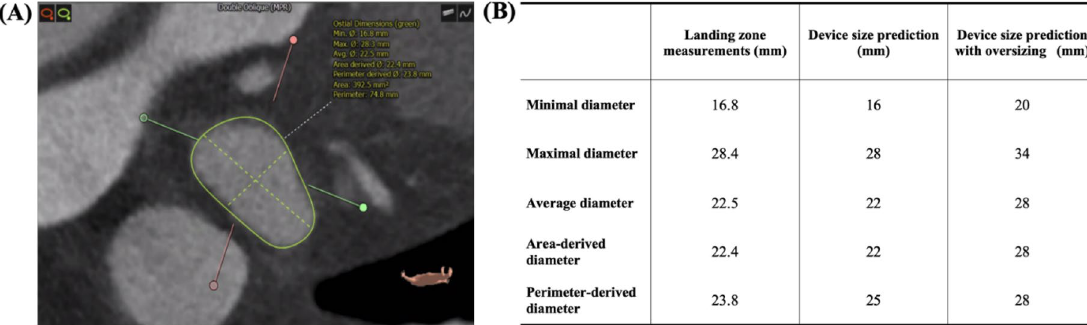
Figure 2. Device size prediction using landing zone measurements. ( A ) The landing zone of the left atrial appendage is located, and five different parameters are acquired: minimal, maximal, average, area-derived, and perimeter-derived diameter. Analysis was performed by 3mensio Workstation version 10.1 (Pie Medical Imaging, Maastricht, The Netherlands). ( B ) Device size is predicted by choosing the closest size to each parameter. Device size prediction with oversizing is performed by choosing the corresponding device size according to sizing gually. Using the bolus tracking technique (Bolus Pro Ultra; Philips Healthcare), the contrast-enhanced scan- ning was initiated after 10 s of triggering with a trigger threshold of 110 Hounsfield Units (HU) ascending aorta. Approximately 50–70 mL of contrast agent (Iomeron 400, 400 mg iodine/mL; Bracco Imaging SpA, Milan, Italy) was injected through the antecubital vein (injection rate = 4.5–5 mL/s) followed by 50 mL of 1:1 mixed contrast saline chaser (4 mL/s) using a dual-head power injector (Stellant; Medrad, Pittsburgh, PA, USA). The presence or absence of an LAA thrombus was assessed using a delayed scan performed 1 min after the contrast injection using prospective ECG-gating centered at 40% of the R-R interval. Images were reconstructed at 0–90% of the R-R interval in 10% increments with a 20-cm field of view, 512 × 512-pixel matrix, 0.9 mm slice thickness, and 0.45-mm image increments with hybrid iterative reconstruction (iDose4; Philips Healthcare) using a medium soft-tissue convolution kernel (XCB, Philips Healthcare, Cleveland, OH, USA). CT image analysis and measurement. CT images were saved as Digital Imaging and Communications in Medicine (DICOM) files and imported into a commercially available software package (3mensio Worksta- tion version 10.1, Pie Medical Imaging, Maastricht, The Netherlands). The images were analyzed by experienced imaging cardiologists (Supplement Fig. 1). In detail, the LAA was automatically located, and landmarks were placed at the left circumflex artery and coumadin ridge to locate the LAA ostium. After adjusting the plane angle, the landing zone was set as 10 mm distal to the ostium. The following ostium and landing zone measure- ments were automatically obtained: the minimal diameter, maximal diameter, average diameter, area-derived diameter, and perimeter-derived diameter. The maximal diameter was defined as the largest distance observed after repeating the measurements between each point. The minimal diameter was the shortest distance that was found in this process, and the average diameter was the mean value of the two. The landing zone area was measured using the shoelace algorithm, summing the divisions of voxels within the area 16,17 . The perimeter was calculated using the length along the lumen line, which is a direct result of lumen segmentation. The area and perimeter-derived diameters were calculated using the equation for the circumference of a circle, dividing each measurement by pi (π) . Supplement Fig. 2 shows representative cases with eccentric or circular landing zones.